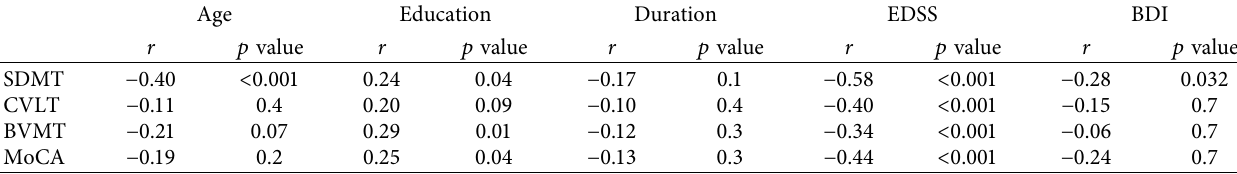
Table 6: Correlation of cognitive tests with patient characteristics and EDSS and BDI scores.